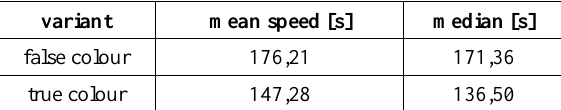
Table 4. Speed of false colour images - true colour: objects of critical infrastructure